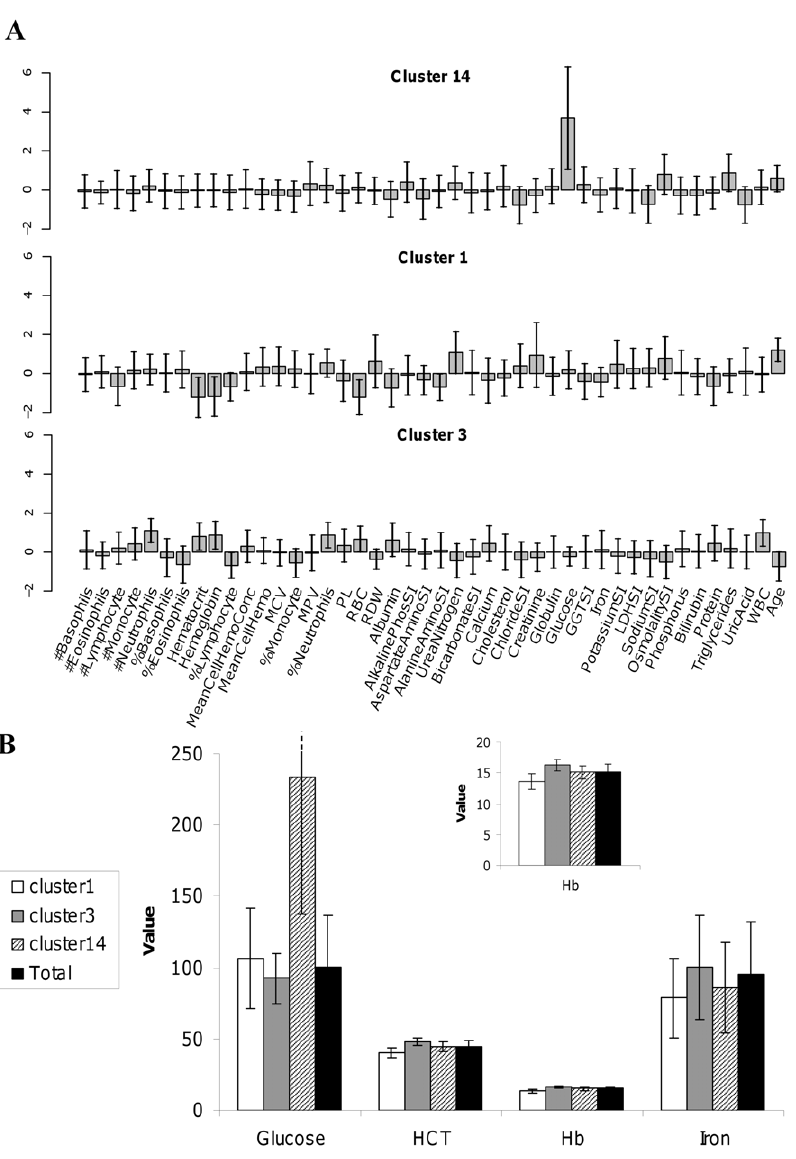
Figure 2. Selected clusters from the NHANES training set. (A) The mean and standard deviation of biomarker values are shown for three selected clusters generated with 4152 males 20 years of age or older from the NHANES training set, using the Z-score normalized/CLICK pre- processing/clustering combination. For each cluster, the total number of individuals (top, right) and selected health/lifestyle traits that are significantly enriched in that cluster (top, left) are provided. For each enriched term, the enrichment factor (i.e. the frequency of the term in a cluster divided by its frequency in the entire dataset) is also provided. (B) Comparison of the original values of selected biomarkers in clusters 1, 3 and 14. The values for Hb are enlarged in the top middle section of the figure.